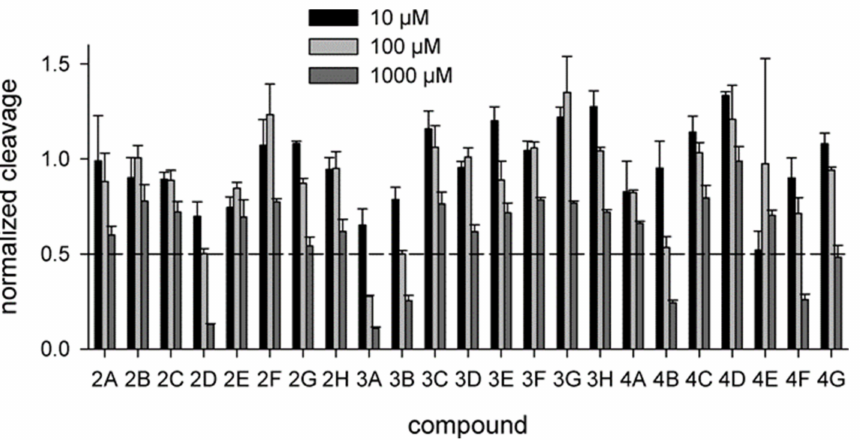
Figure 5. Biochemical screening of the inhibitors against vvUNG. The inhibitor concentration was 10 µ M (black bars), 100 µ M (light gray bars), or 1000 µ M (dark gray bars). The activity is normalized for that in the absence of the inhibitor. Means and SD of three independent experiments are